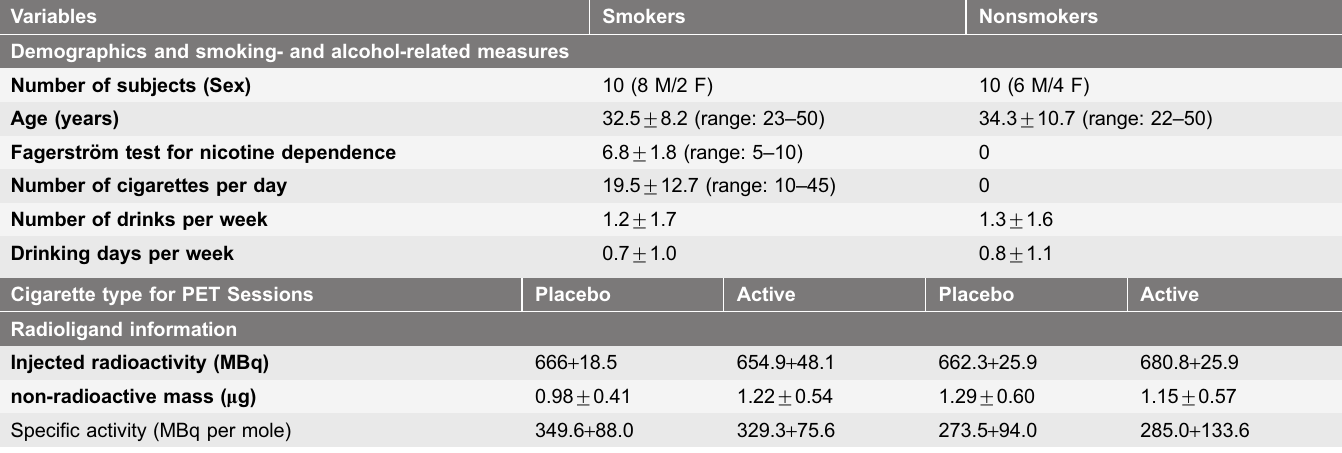
Table 1. Demographics of participants and radioligand information of placebo and active cigarette